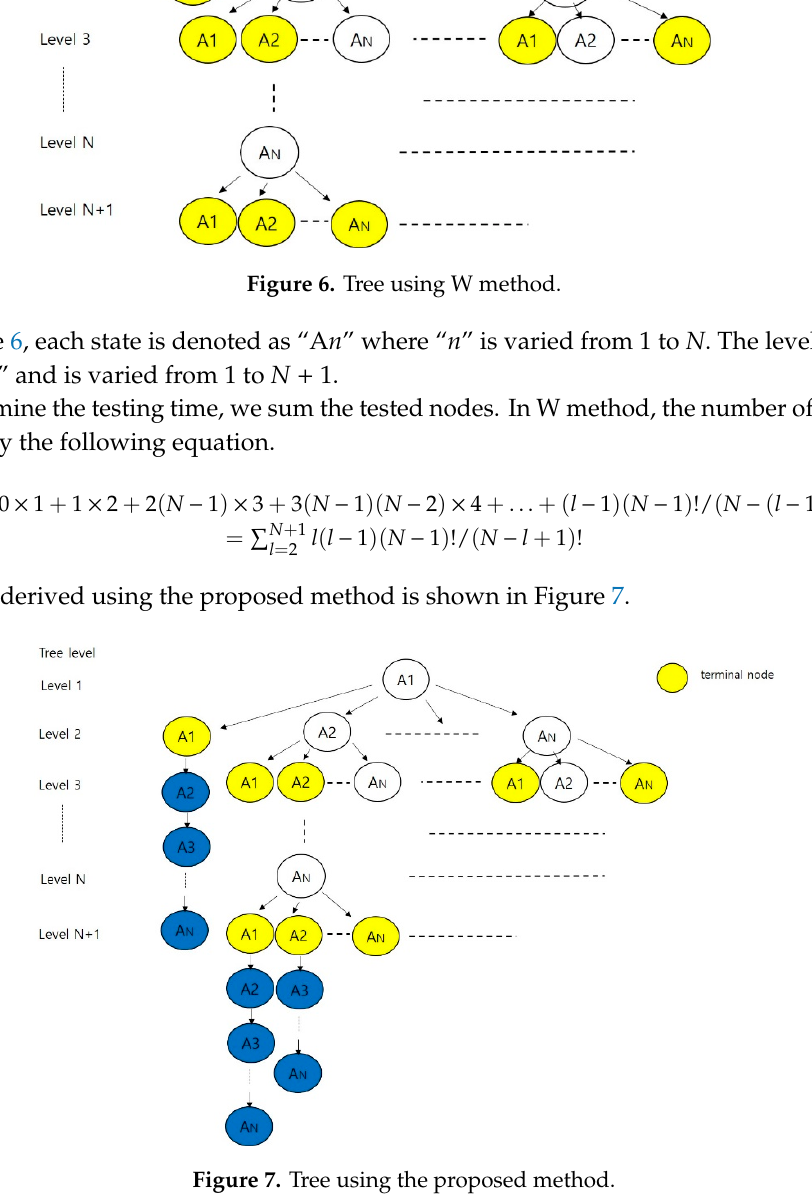
Figure 5. Sample FSM for testing time analysis.